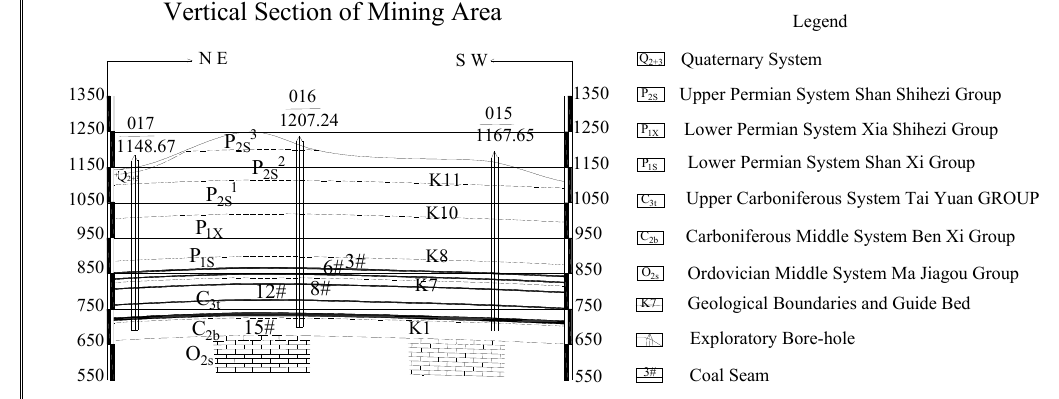
Figure 2. Vertical section of mining area. # represents coal seam number.